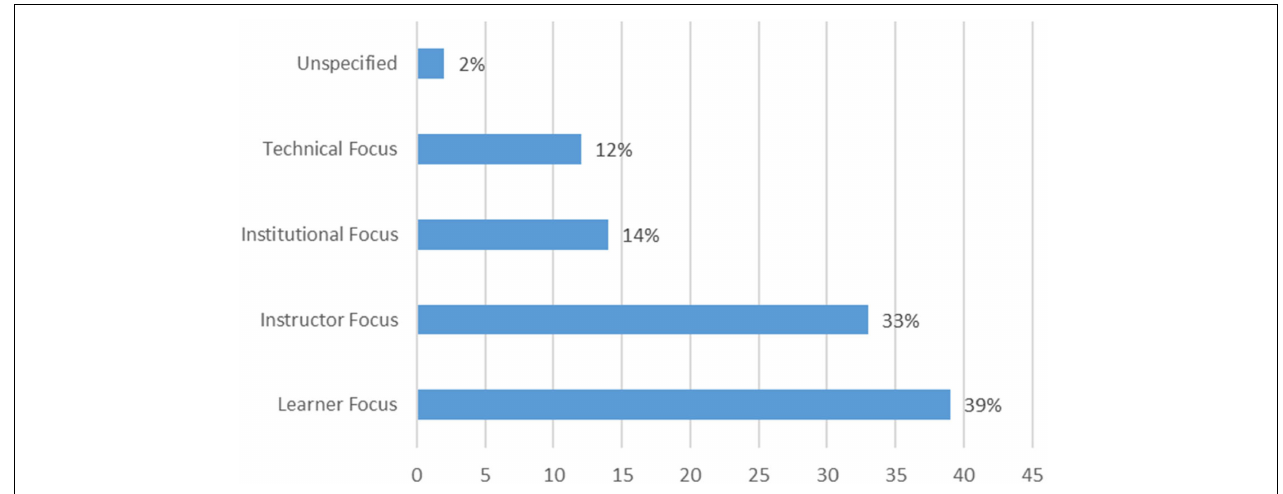
FIGURE 1 | Distribution of studies in systematic mapping by primary focus of the investigation, in percent (Otto et al., 2021).